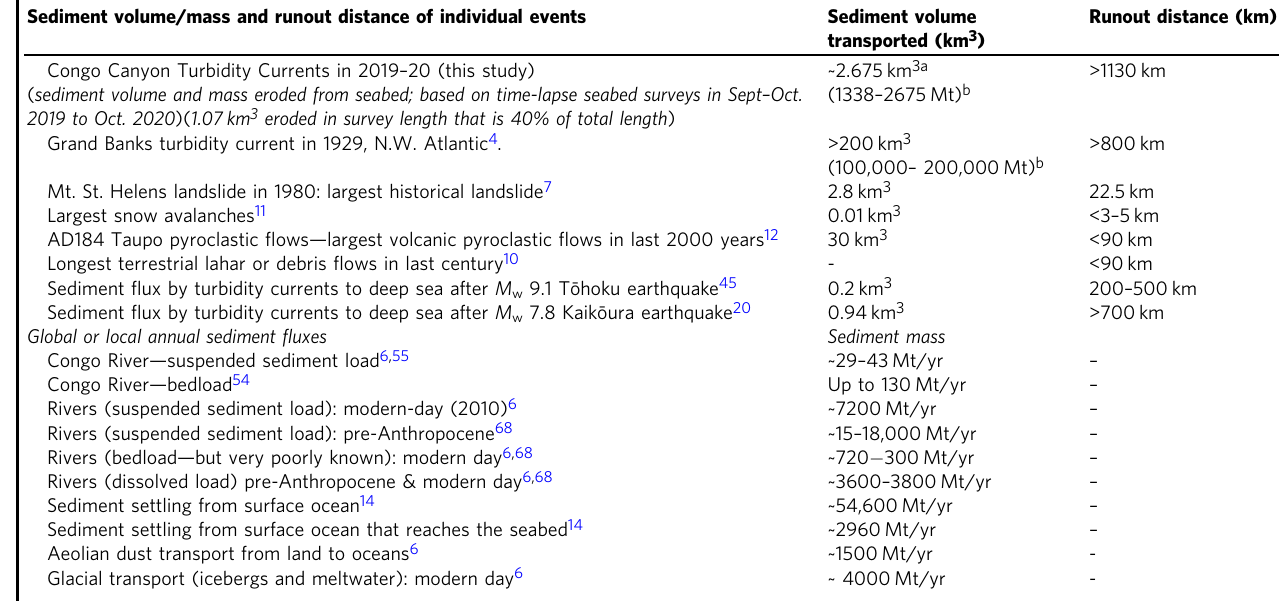
Runout distance (km) transported (km 3 )